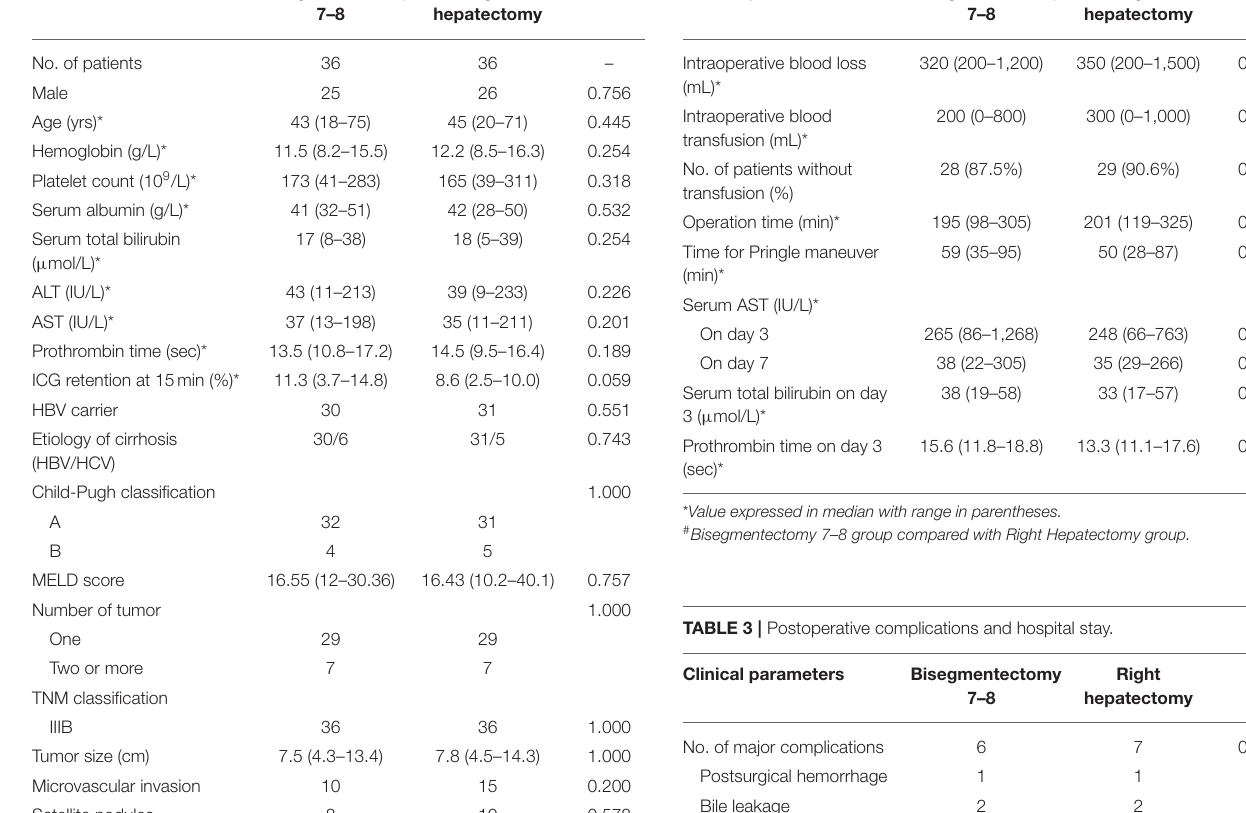
TABLE 1 | Patient demographics and tumor characteristics. TABLE 2 | Intraoperative parameters and postoperative courses of liver function. Clinical parameters